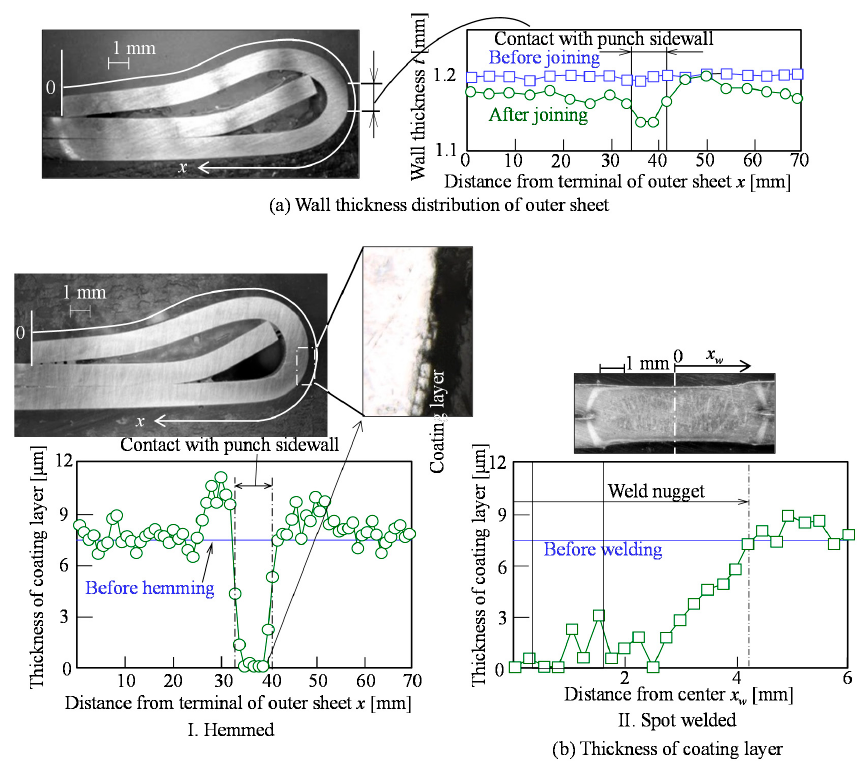
Figure 12. Distributions of wall thickness and coating layer thickness in joined outer sheet for 1180 MPa steel sheets.